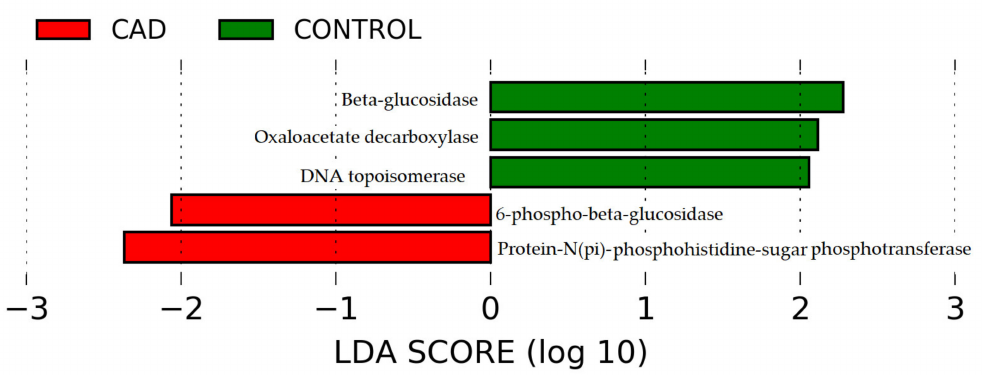
Figure 5. Potential changes in microbiome products in coronary artery disease and control groups at the protein